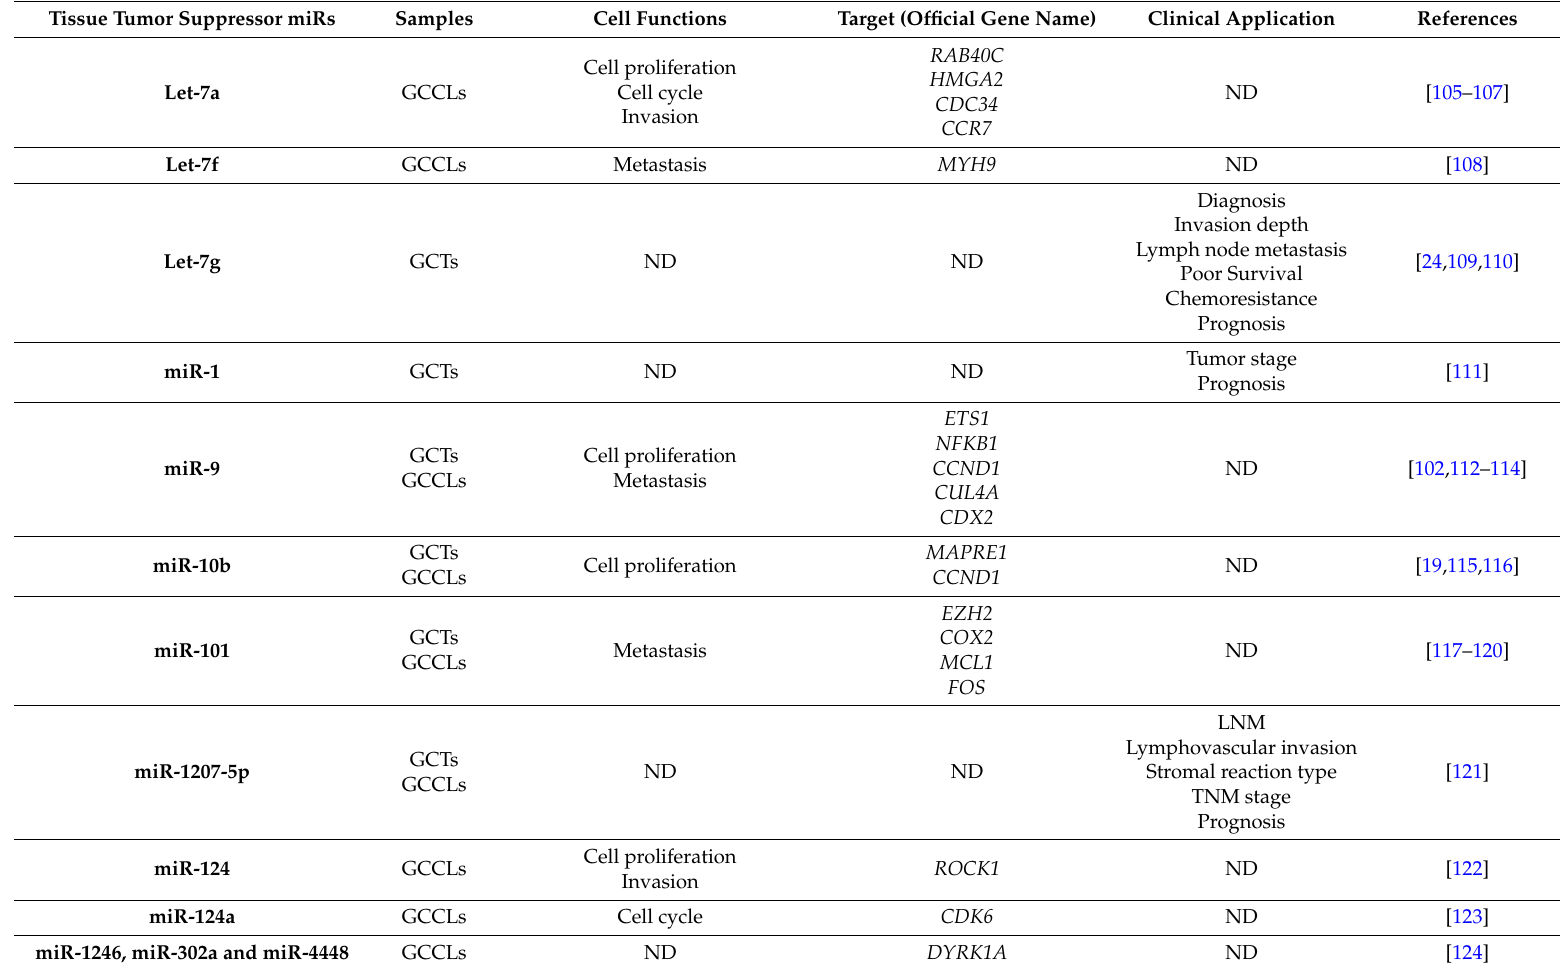
Table 2. Down-regulated miRNAs in tissues for